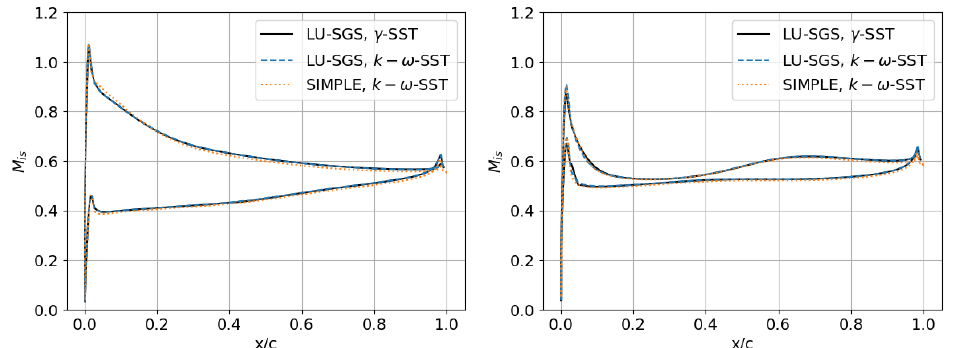
Figure 7. Mach number distribution over middle blade obtained with three different numerical models (left pane α = − 3°, right pane α =